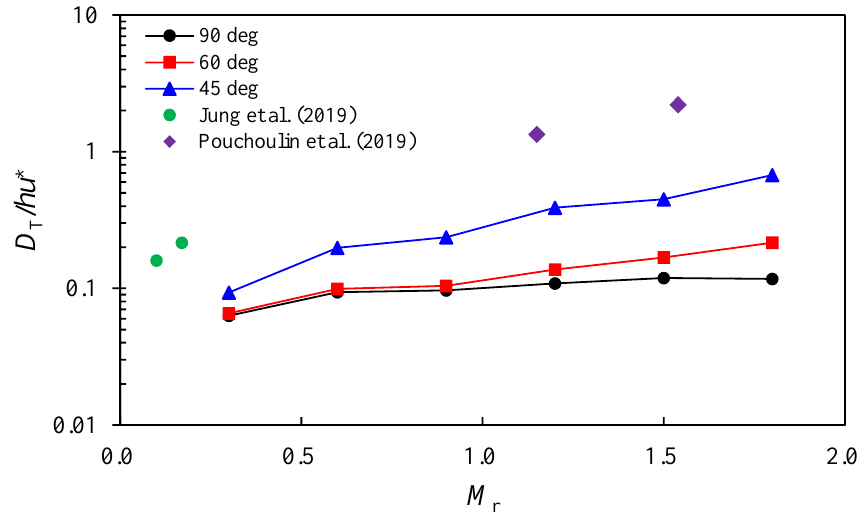
Figure 11. Change of the transverse dispersion coefficient according to the momentum ratio [8,21].